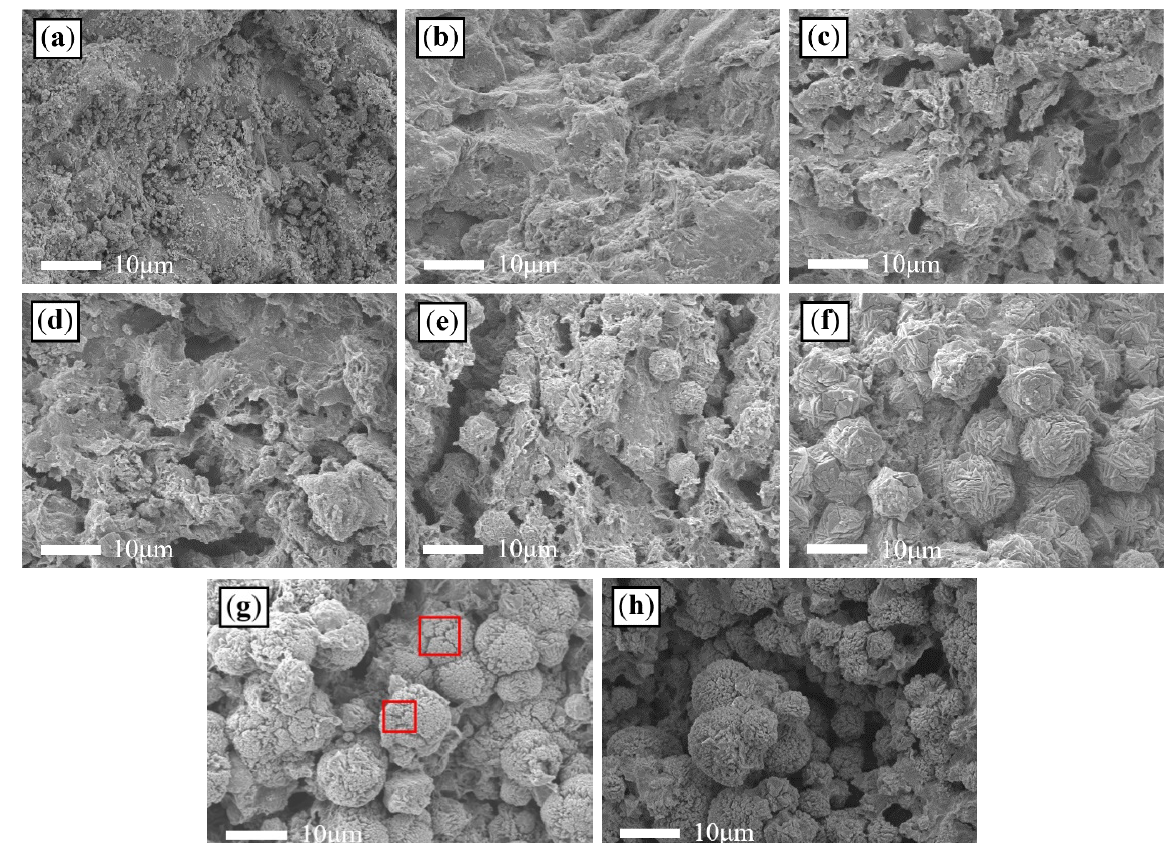
Figure 4. SEM images of natural and NaP zeolites. Morphology variation with different reaction times; ( a ) natural zeolite, ( b ) 10 min, ( c ) 1 h, ( d ) 2 h, ( e ) 9 h, ( f ) 24 h, ( g ) 48 h, and ( h ) 60 h.